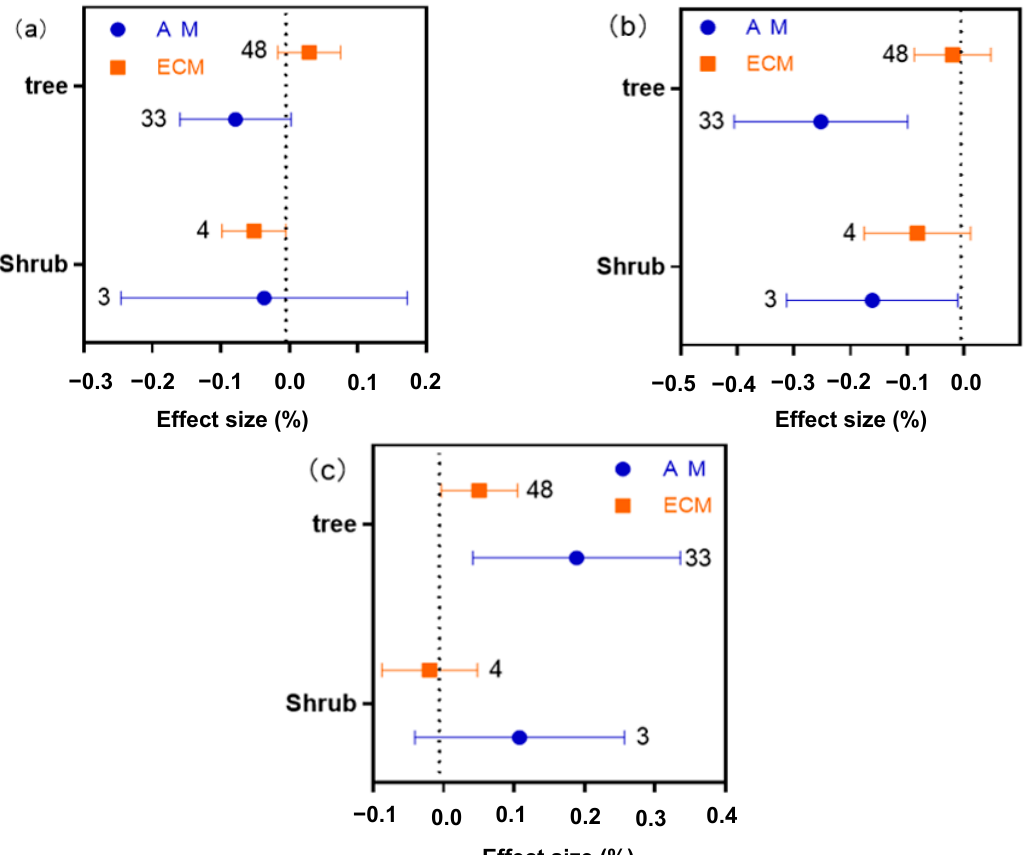
Figure 4. Effects of drought on AM and ECM plant N ( a ), P ( b ), and N:P ratio ( c ) were classified by tree and shrub . 2.6. Overall Difference and Distribution Range of N, P, and N:P Ratio Effects of Drought on AM and ECM Plants